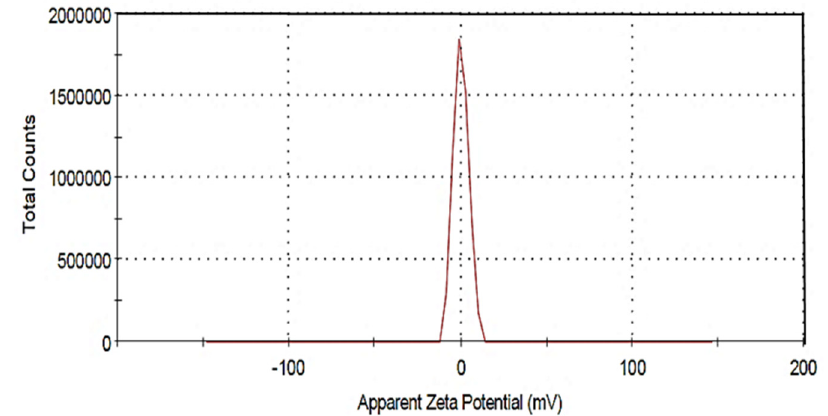
Figure 4. Zeta -potential distribution for ZVI nanoparticles suspension.